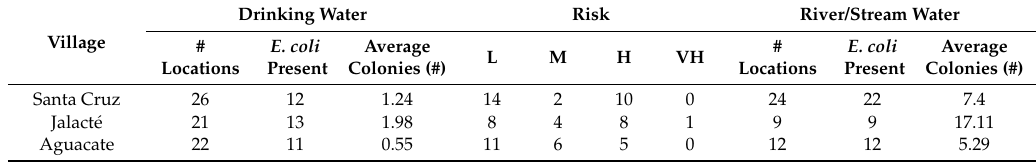
Table 5. Summary of E. coli contamination results in drinking water, rivers, and streams. Associated risk levels (see Table 3) for disease transmission from drinking each water source are shown in the middle four columns. L, M, H, and VH stand for Low, Medium, High, and Very High risk levels respectively. Drinking Water Risk River/Stream Water Village E. coli E. coli # Average # Average L M H VH Locations Present Colonies (#) Locations Present Colonies (#) Santa